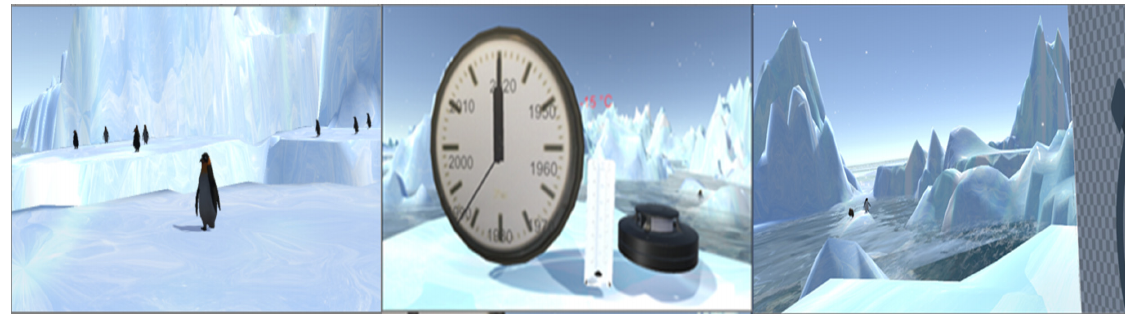
Figure 3. Antarctic in the 1950s (left), timer, thermometer, CO2 concentration meter data monitoring in the Antarctic in the 1990s (middle), Antarctic in the 2020s (right).